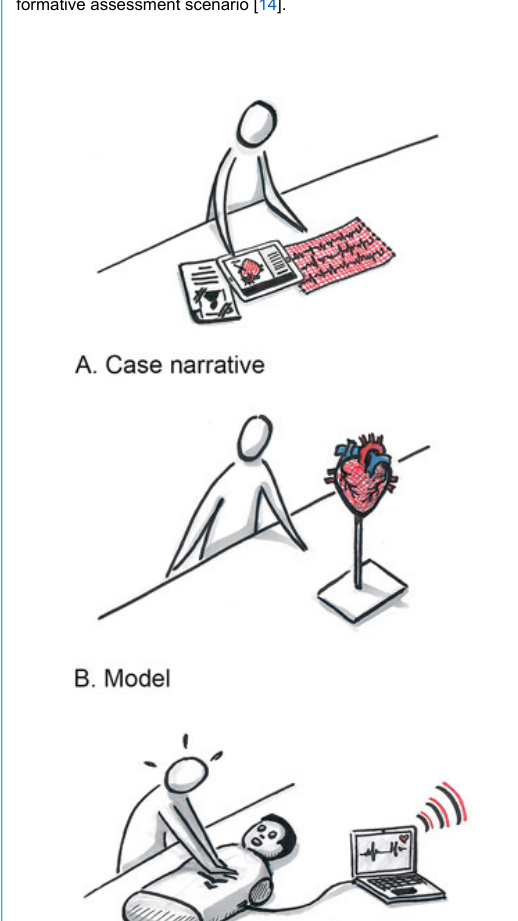
Figure 1: Various forms of patient representation. (A) Case narra- tives: a narrative approach describes a patient and their medical history [1], not unlike a doctor’s letter. Narratives are often based on a real patient’s story. Delivered in text or digitally and some- times media-enriched, these patient representations are often en- countered in problem-based learning settings, in blended-learning scenarios or as virtual patients [2]. (B) Anatomical models , includ- ing cadavers [3] and some e-learning/virtual reality tools [4], are patient representations that reduce physiological complexity to em- phasise anatomy. They are used in undergraduate education